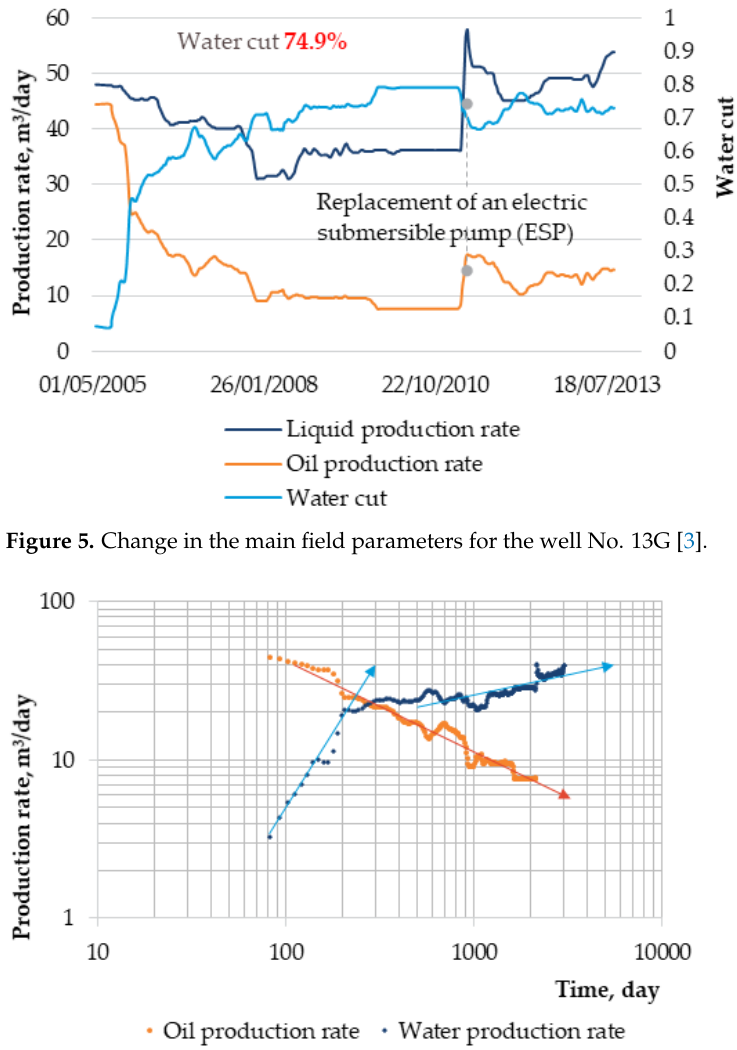
Figure 6. Oil and water production curves in double logarithmic coordinates for the well No. 13G [3].